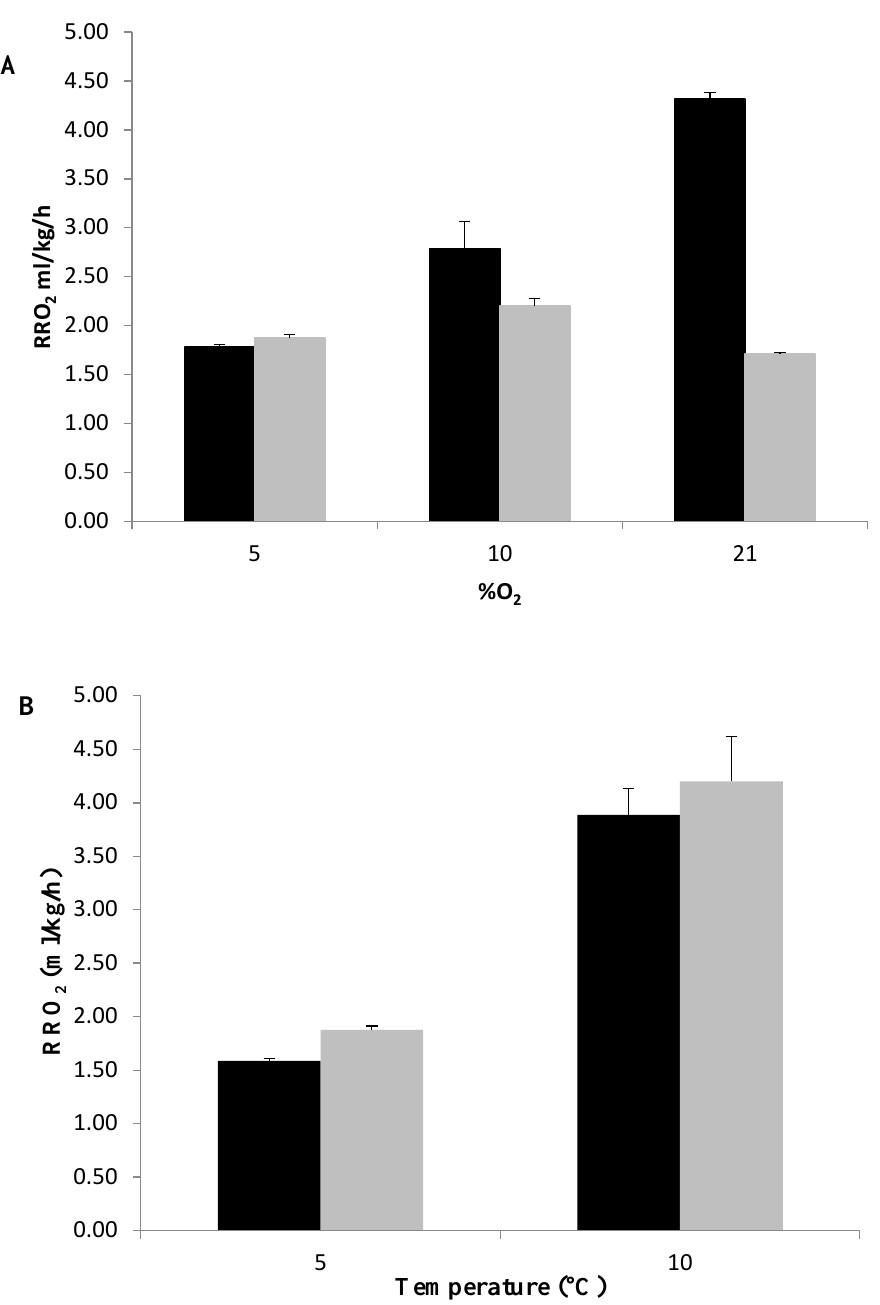
Figure 1. Respiration rate expressed as rate of oxygen consumption (RRO 2 ) of control sample ( ■ ) and coated sample ( ■ ) as function of oxygen concentrations at 5 °C ( A ) and as function of temperature at 5% of oxygen ( B ).